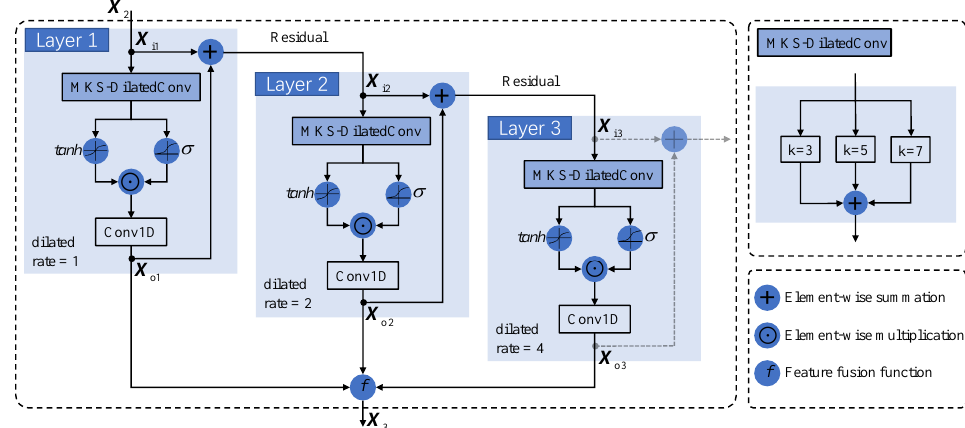
Figure 3. Multi-scale temporal convolution